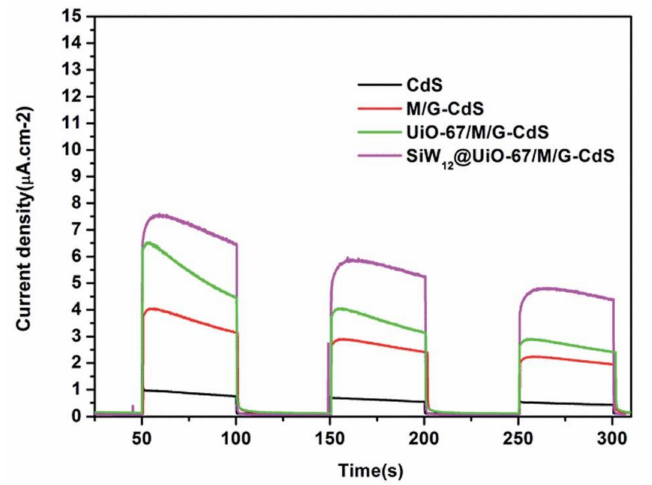
Figure 5. Transient photocurrent responses of the materials involving CdS, M/G-CdS, UiO-67/M/G- CdS, and SiW 12 @UiO-67/M/G-CdS under visible light irradiation